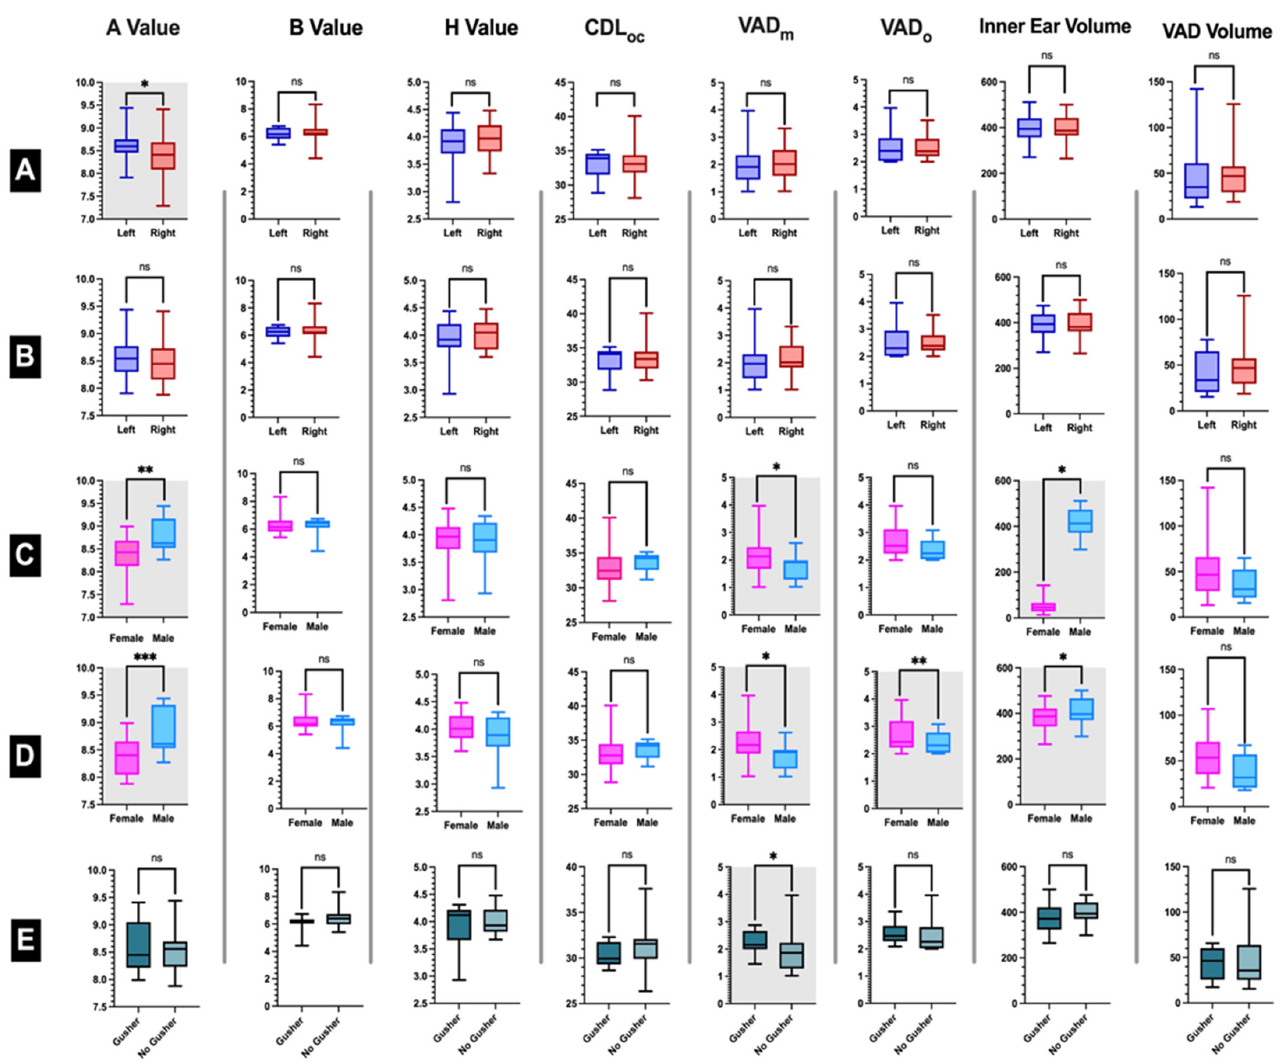
Figure 2. Descriptive characteristics of the study cohort. ( A ) Descriptive Statistics of the whole population (N = 42) by side of the ear (described as mean ± SD, Minimum, and Maximum, ( B ) Baseline characteristics for Cochlear Implanted ears (N = 33) by side of the ear, ( C ) Descriptive Statistics of the whole population (N = 42) by sex (described as mean ± SD, Minimum, and Maximum, ( D ) Baseline characteristics for Cochlear Implanted ears (N = 33) by sex, ( E ) Descriptive statistics of Cochlear implantation patients’ ears by Gusher outcomes, *: Significant p -Value ( p ≤ 0.05), **: Significant p -Value ( p ≤ 0.01), ***: Significant p -Value ( p ≤ 0.001), ns: nonsignificant p -Value ( p > 0.05), CDL: cochlear duct length, OC: organ of corti, VADm: vestibular aqueduct width at the midpoint, VADo: vestibular aqueduct width at the operculum). Male is colored light blue, Female is colored pink, Right is colored red, Left is colored dark blue, Gusher is colored dark green, and No gusher is colored light